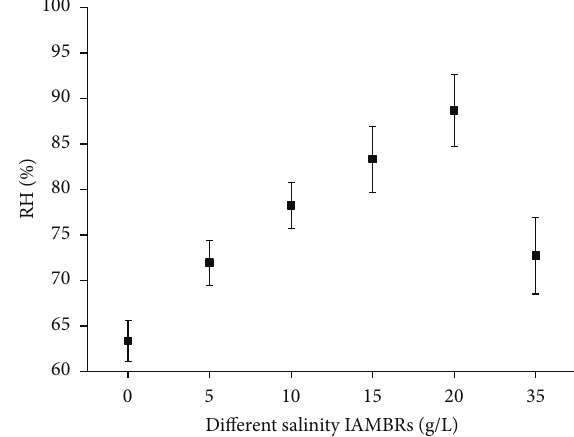
Figure 5: The variation of RH at different salinity.